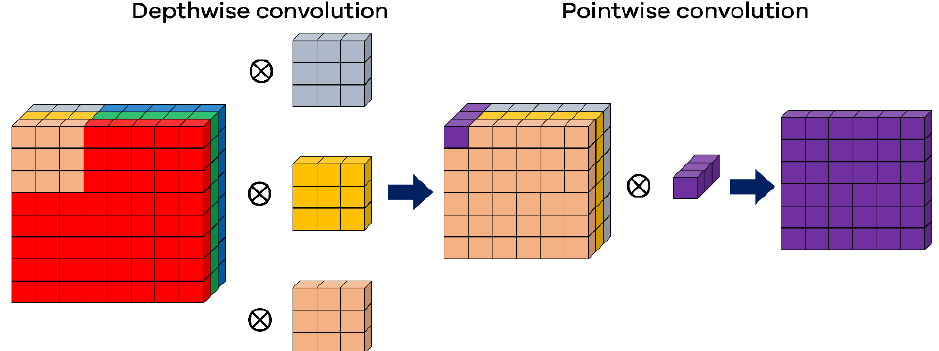
Figure 9. Depthwise separable convolution.